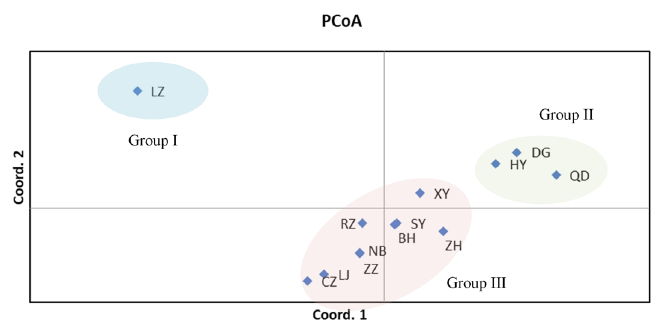
Figure 4. Principal coordinate analysis of genetic similarity among 13 clam populations.